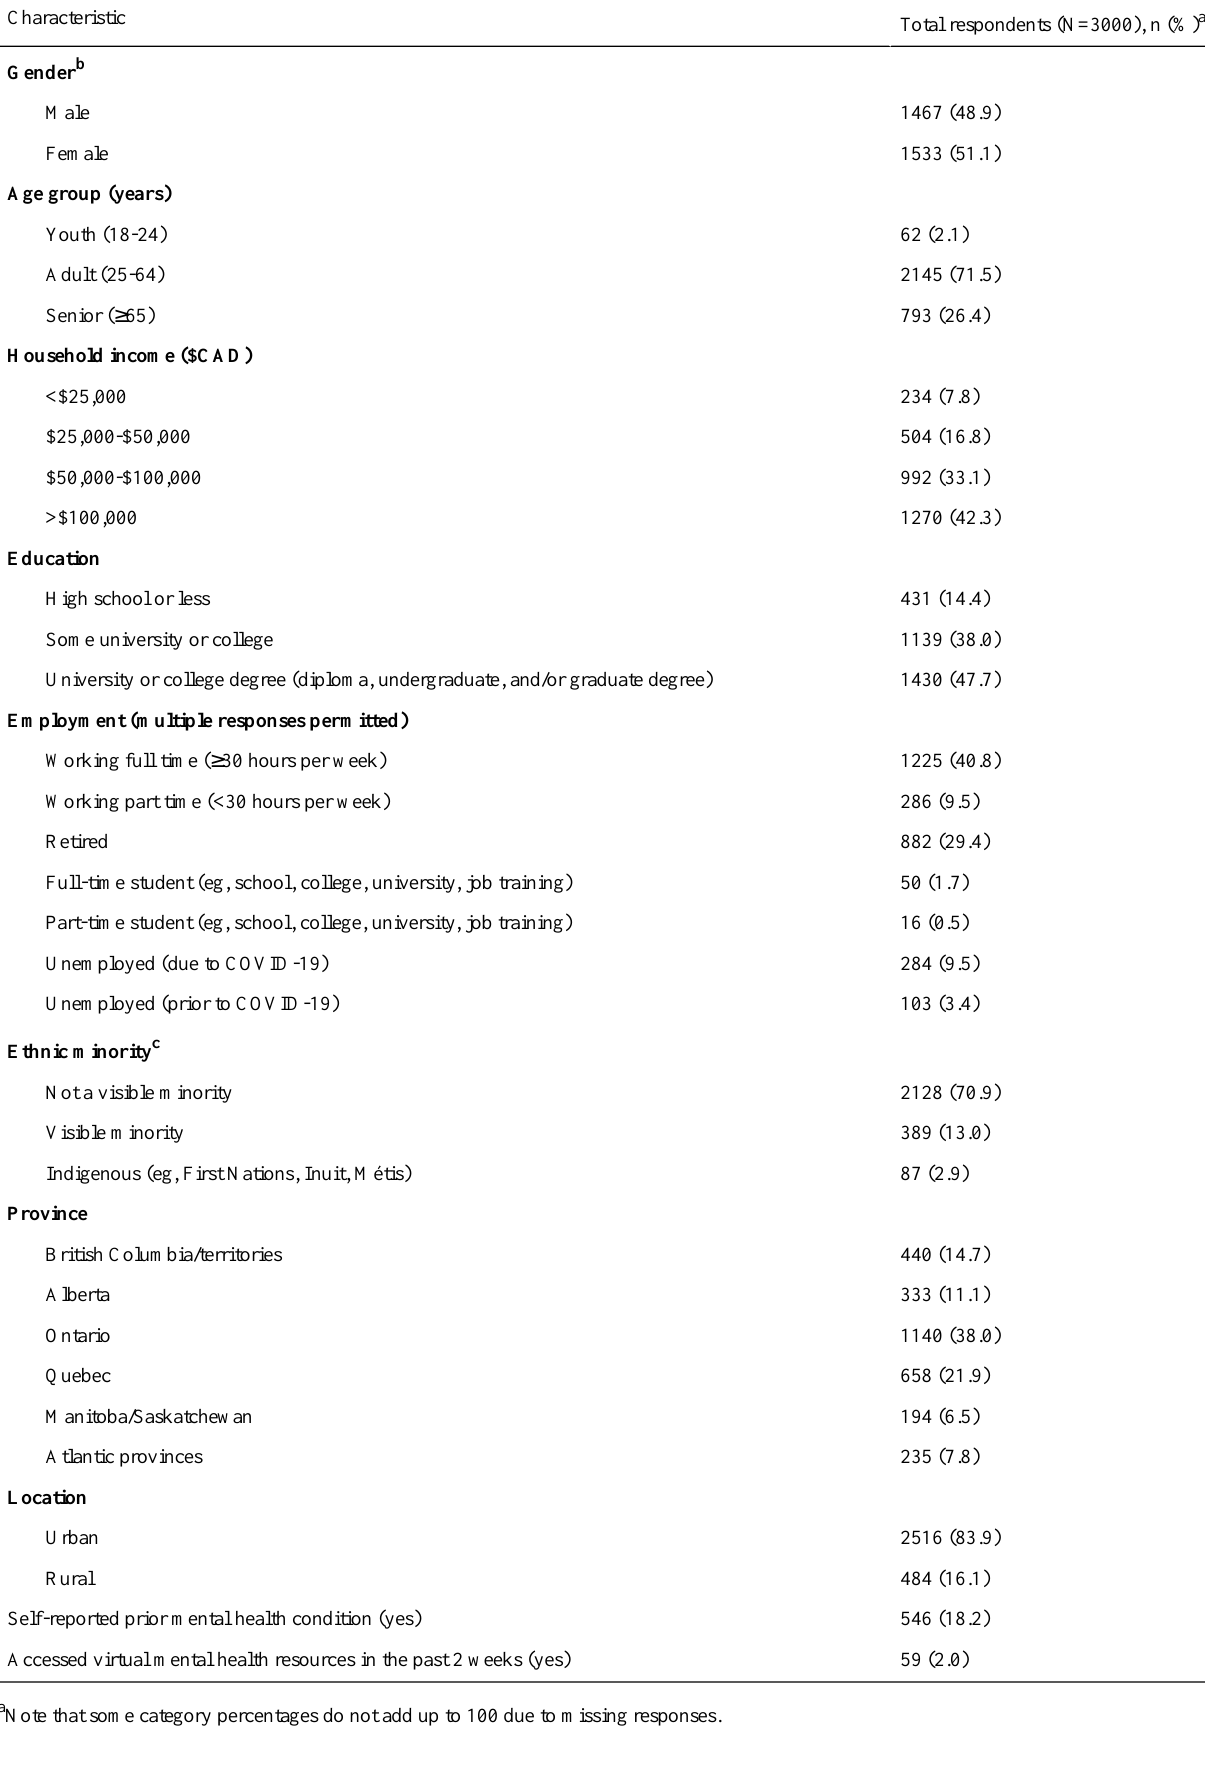
Table 1. Sociodemographic characteristics of the